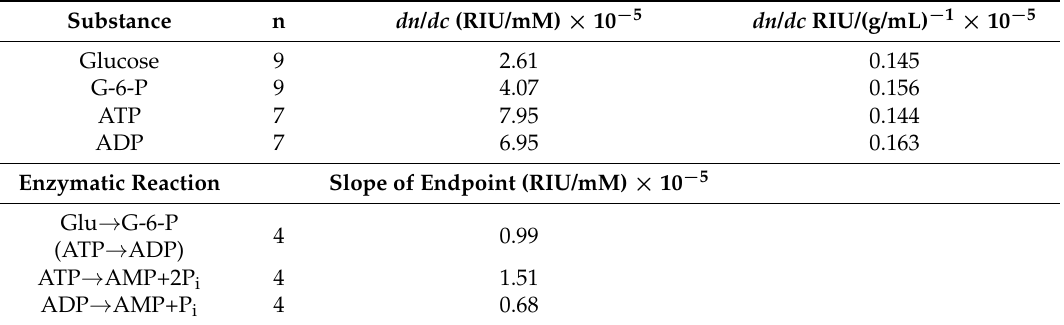
Table 1. Summarized findings of the dn / dc value and the slope of the endpoint values vs. substrate concentration. n is the number of solutions in each standard curve and substrate solutions in the enzymatic